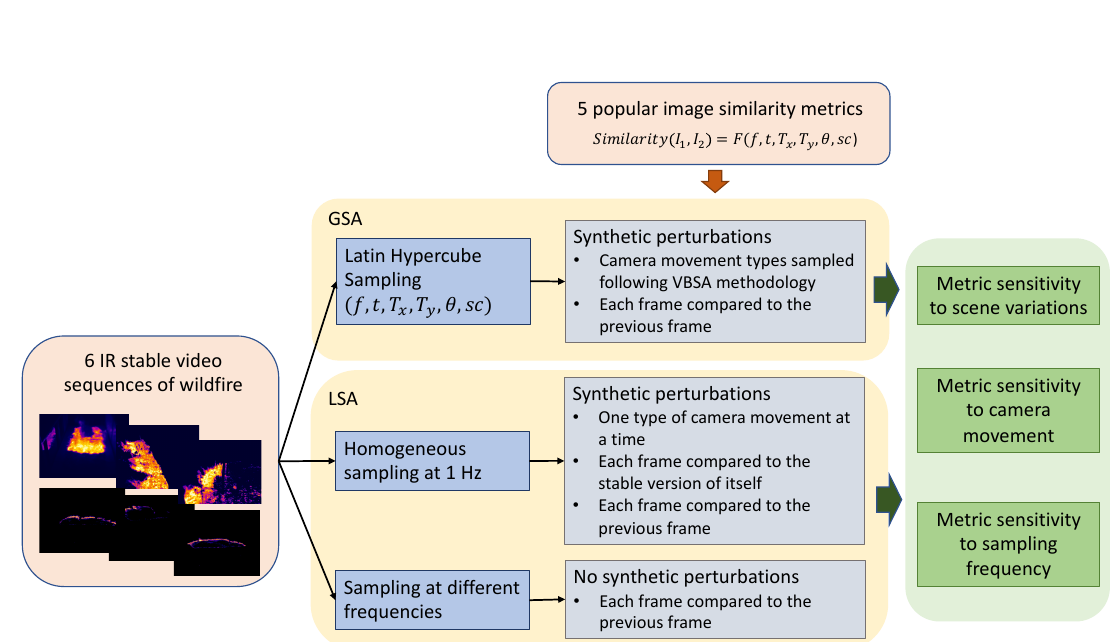
Figure 1. Design of the comparative analysis conducted to assess the behavior of various image similarity metrics. Desired properties were high sensitivity to camera movement and low sensitivity to scene variations and sampling frequency. LSA was applied to the 6 available video sequences. GSA was applied to sequences 1, 2, 4 and 5 due to computational